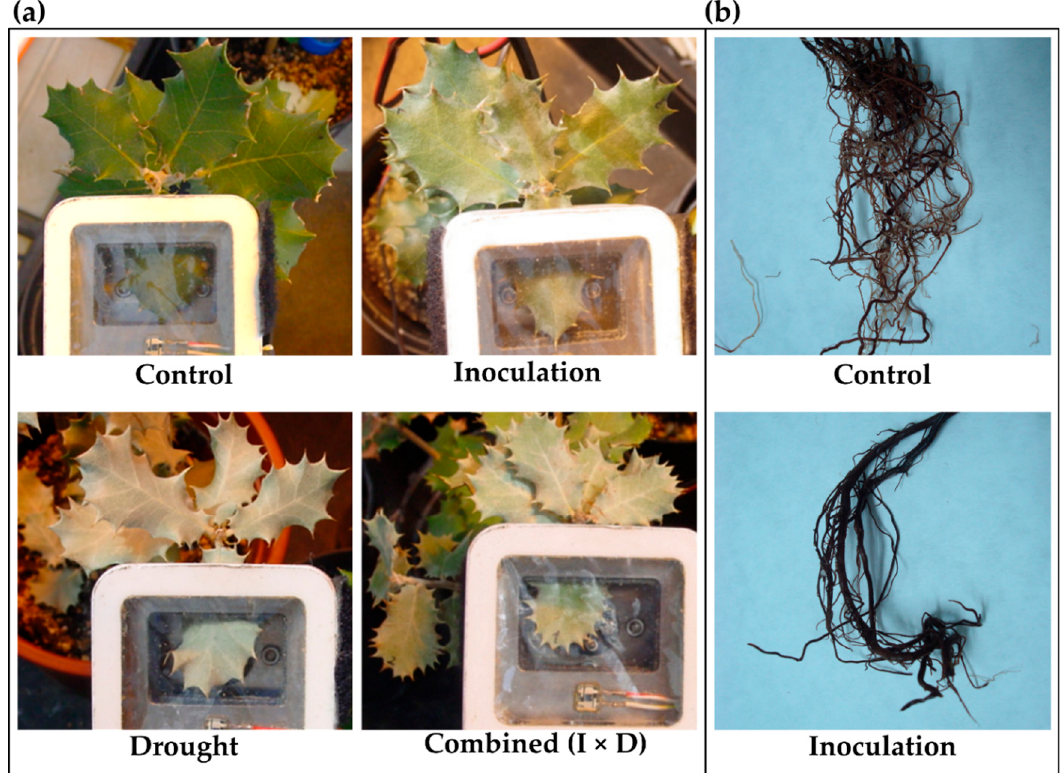
Figure 1. Plant symptoms after 30 dpi. ( a ) Leaf symptoms for the different treatments ( b ) Detail of roots showing root rot symptoms of inoculated plants in comparison to control. “I × D” = Pots non-watered and inoculated with P. cinnamomi Rands.